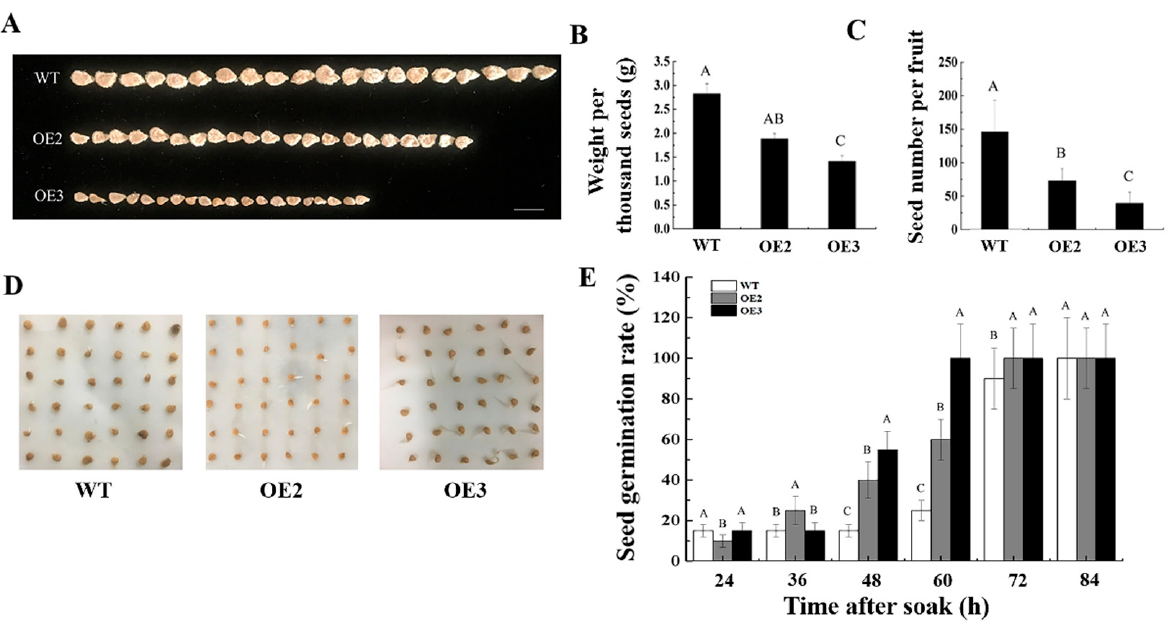
Figure 5. Variations in seed size and germination rate between wild type tomato and transgenic lines. ( A ) Comparison of seeds size between wild type (WT) plants and two transgenic lines OE2 and OE3. ( B , C ) Statistical analysis for variations in two seed-related parameters, weight per thousand seeds ( B ) and seed number per fruit ( C ), between WT, OE2, and OE3. ( D ) Comparison of seed germination rate between WT, OE2, and OE3. ( E ) Statistical analysis for variations in seed germination rate between WT, OE2, and OE3. Data are displayed as mean ± standard deviation of five biological repeats in ( B ), of 20 fruit samples in ( C ), and of six independent experimental repeats in ( E ). Different capital letters indicate significant differences at the statistical level of 0.01 (unpaired two-tailed t